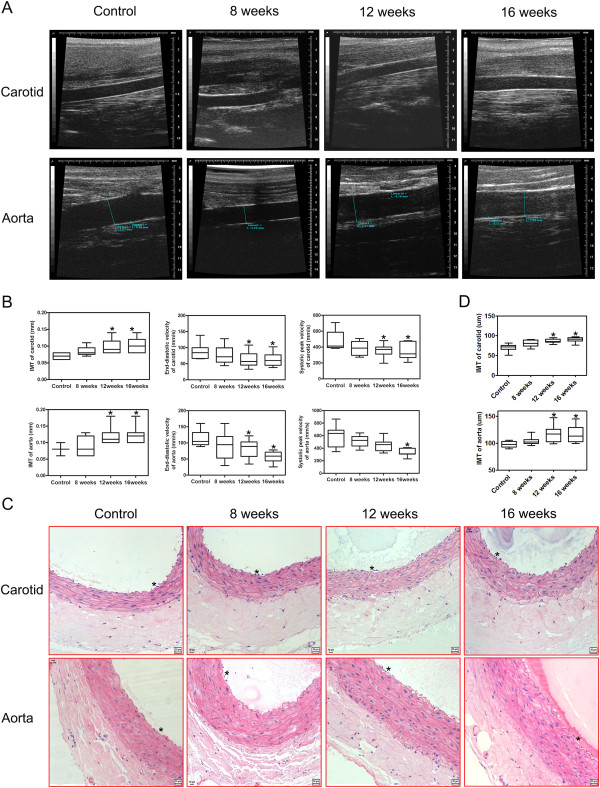
Ultrasound and histological findings of the carotid artery and the aortas in rats. (A) Ultrasound findings of the carotid artery and the aortas from rats fed a high-fat diet for 8, 12 and 16 weeks, respectively. (B) The IMT and hemodynamic parameters such as the end-diastolic velocity, the systolic peak velocity of the carotid artery and the aortas in rats fed with a high-fat diet for 8, 12 and 16 weeks,were measured by ultrasonography. (C) H&E staining of the carotid artery and the aortas sections (objective lens, ×20). The carotid artery and the aortas in rats fed with a high-fat diet for 12 and 16 weeks show mild intimal thickening and cellular hypertrophy in the intima and media of the carotid artery and the aortas. (D) IMT of the HE stained carotid artery and abdominal aorta was measured and quantified. Results represent medians (25/75th percentiles) of 9 rats per group. *P < 0.05 vs. the control group.